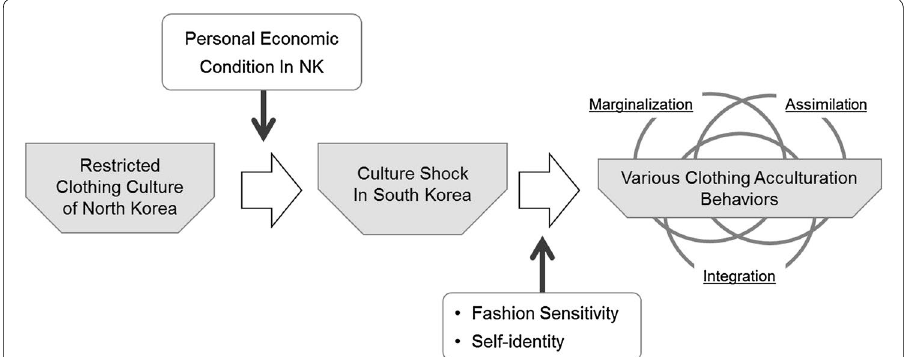
Fig. 1 Clothing acculturation paradigm model of North Korean female